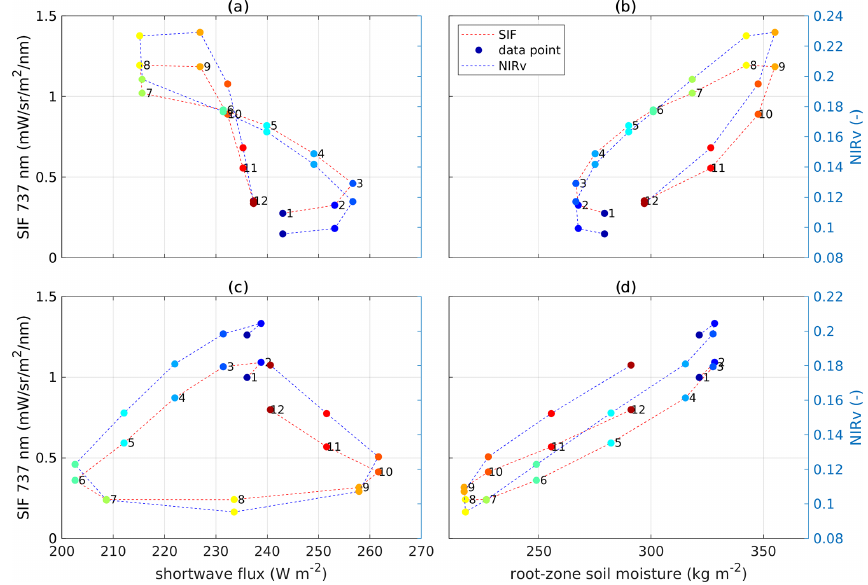
Figure 5. Relation between SIF/NIRv with downward shortwave radiation (a, c) and root zone soil moisture (b, d) for major African biomes. (a, b) Results over the vegetated regions of northern Africa (north of the Equator). (c, d) Results for southern Africa (south of the Equator). The numbers in the plot and the color of the markers refer to the month of the year.